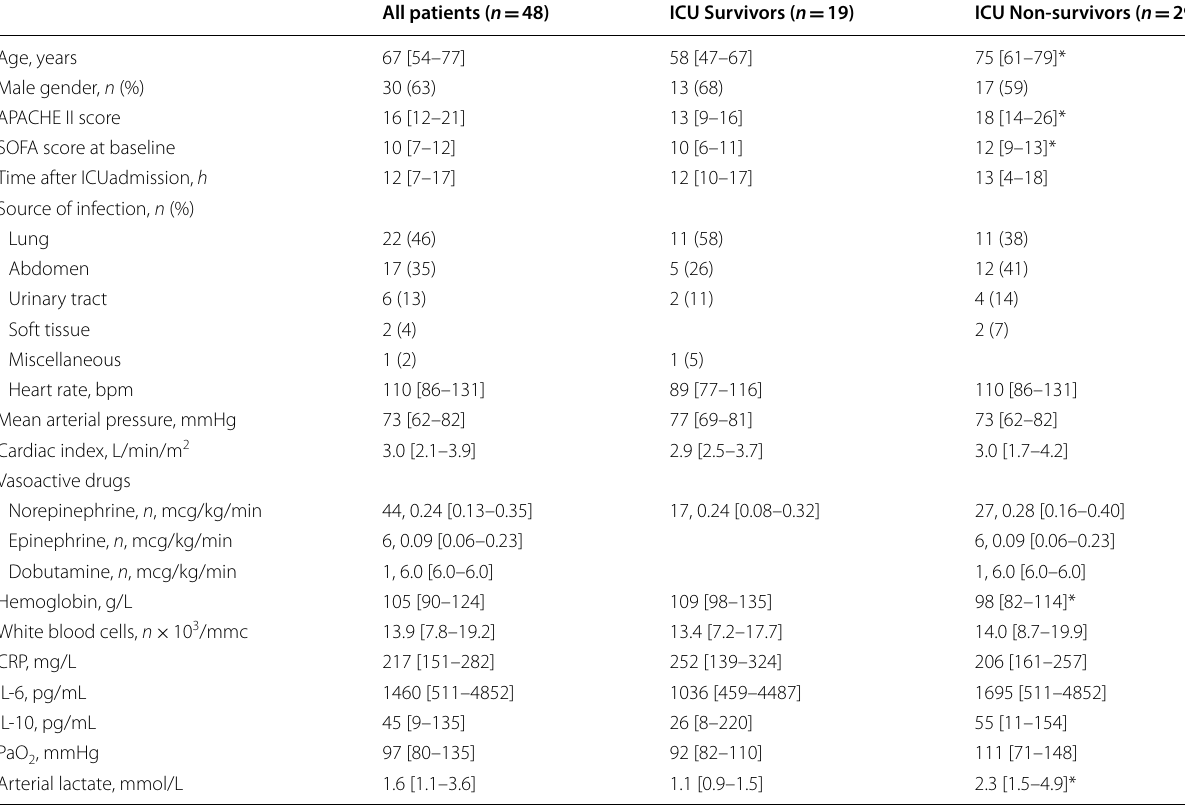
Table 1 Baseline characteristics of the study group and comparison between ICU survivors versus